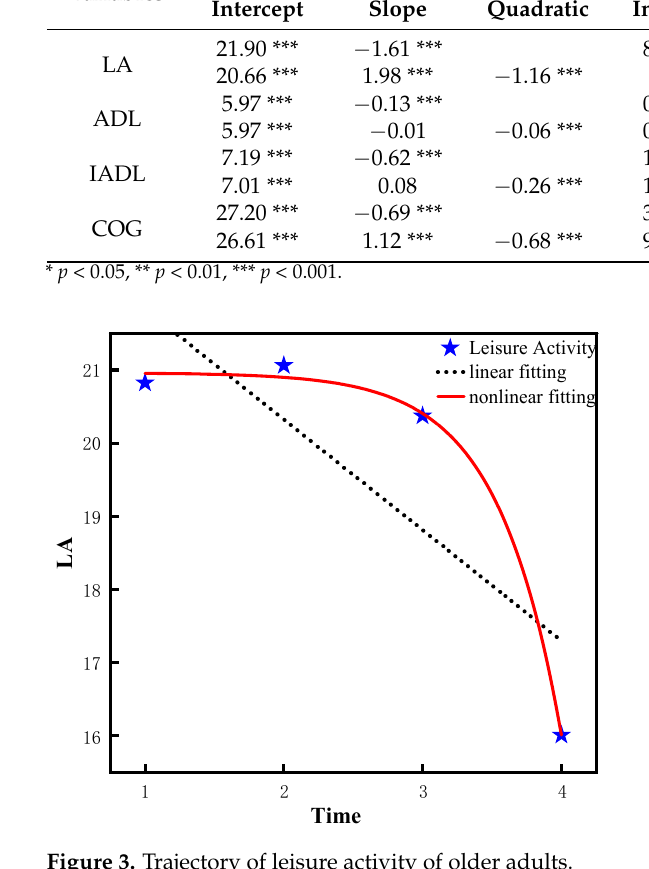
Figure 3. Trajectory of leisure activity of older adults.